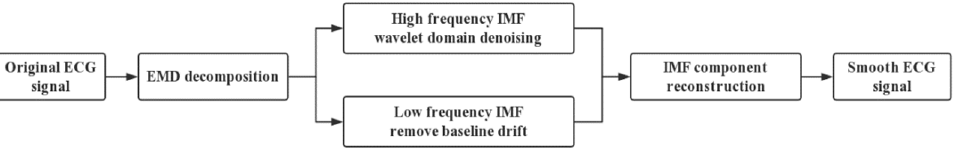
Figure 3. ECG signal processing flow based on empirical mode decomposition (EMD).